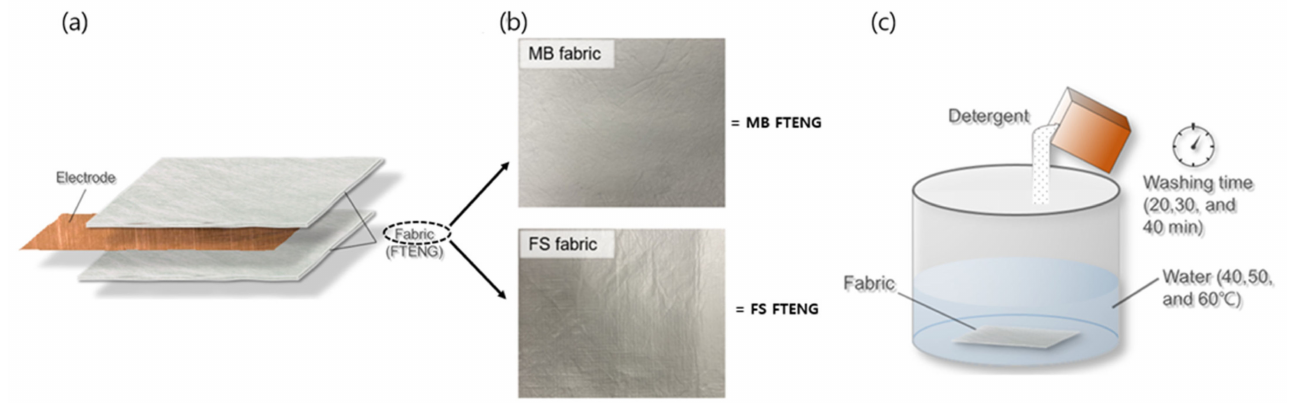
Figure 2. ( a ) Schematic of a FTENG. Photographic surface images of ( b ) melt-blown nonwoven (MB) and flash-spun nonwoven (FS) fabric sheets and ( c ) experimental schematic of washing